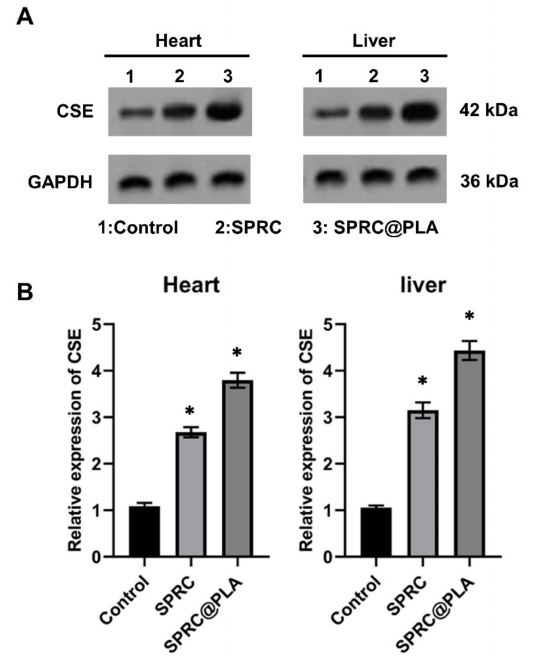
Figure 6. (A) The expression of CSE in hearts and liver of rats determined by Western blot and ( B ) the relative expression fold changes. GAPDH was used as a loading control and (*) indicated significant different as compared with the control group ( n = 5, mean ±